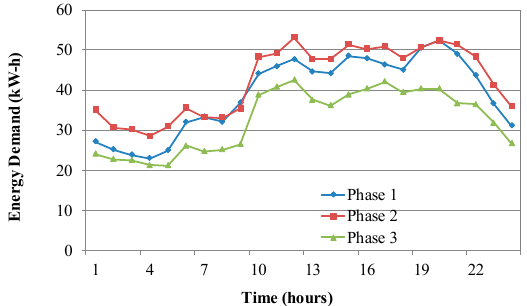
Figure 10. Balanced demand curves for Bariloche, Argentina.